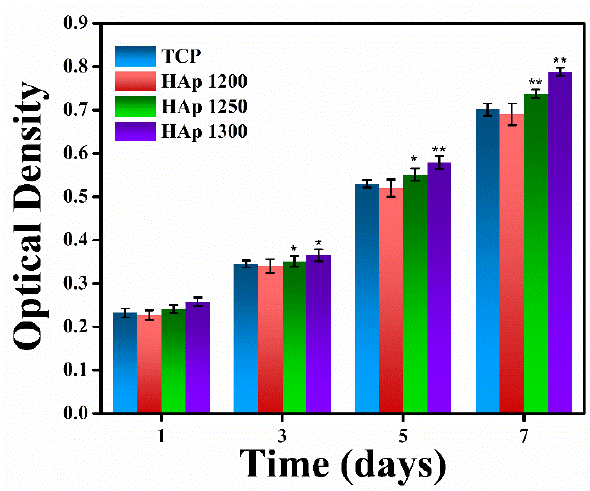
Figure 8. MTT assay of MG-63 cells cultured on HAp samples (sintered at different temperatures) for 7 days. * and ** correspond to significant differences at p < 0.05 and p < 0.01, respectively.